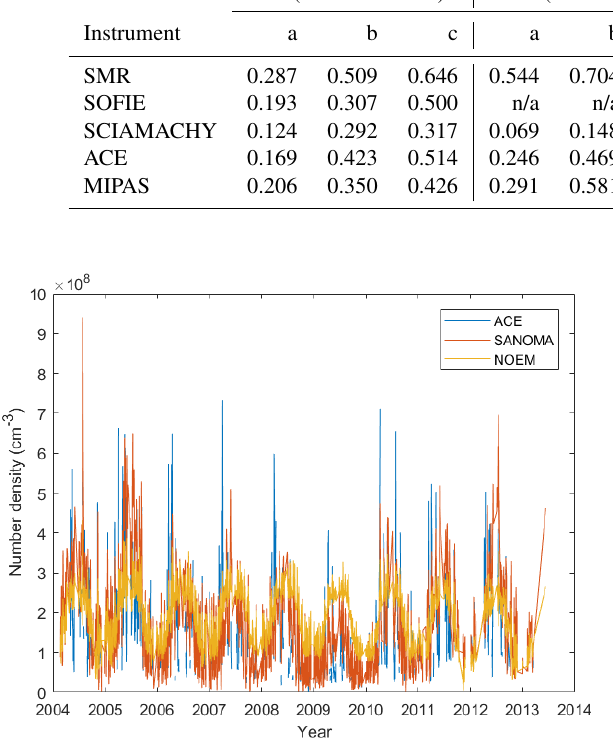
Figure 19. Time series of NO number density measured with ACE and simulated with SANOMA as well as NOEM, 102km altitude, − 70 ◦ (cid:51)